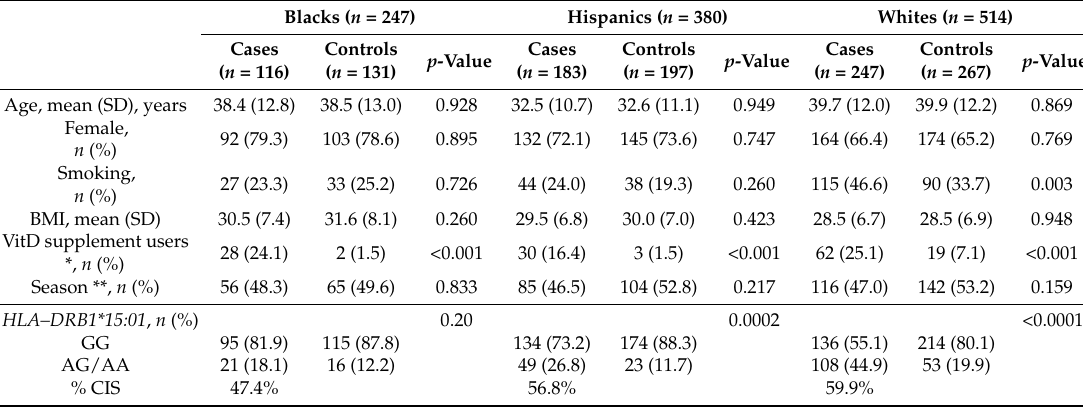
Table 1. Selected Characteristics of Study Participants at Index Date by Race/Ethnicity.